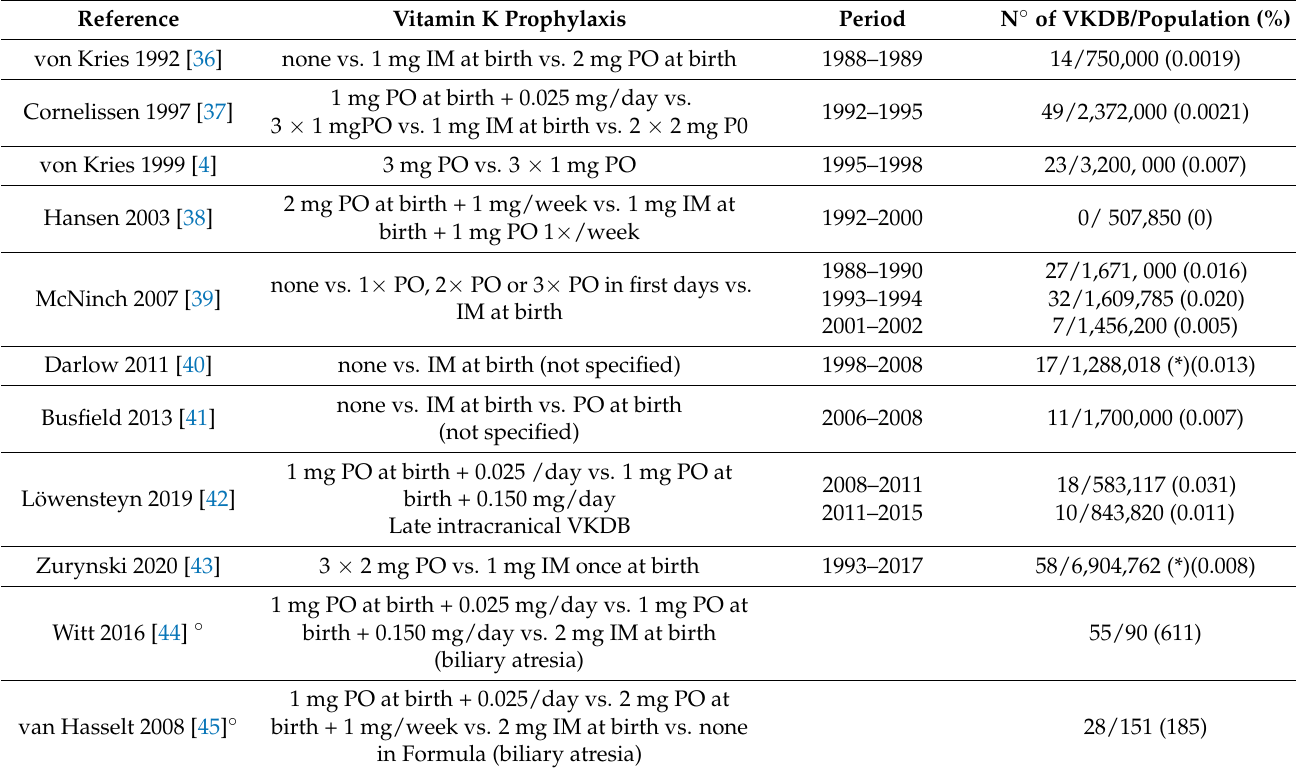
Table 2. Summary of included registry studies in the literature